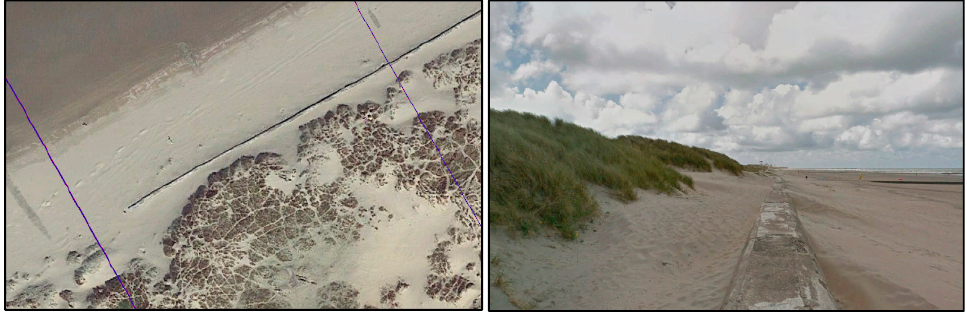
Figure 17. Concrete wall as a dune foot protection measure in section 72.